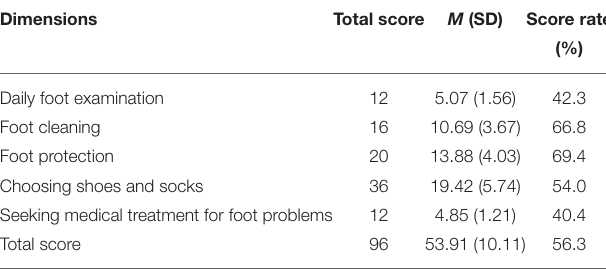
TABLE 4 | Practice scores of diabetic foot